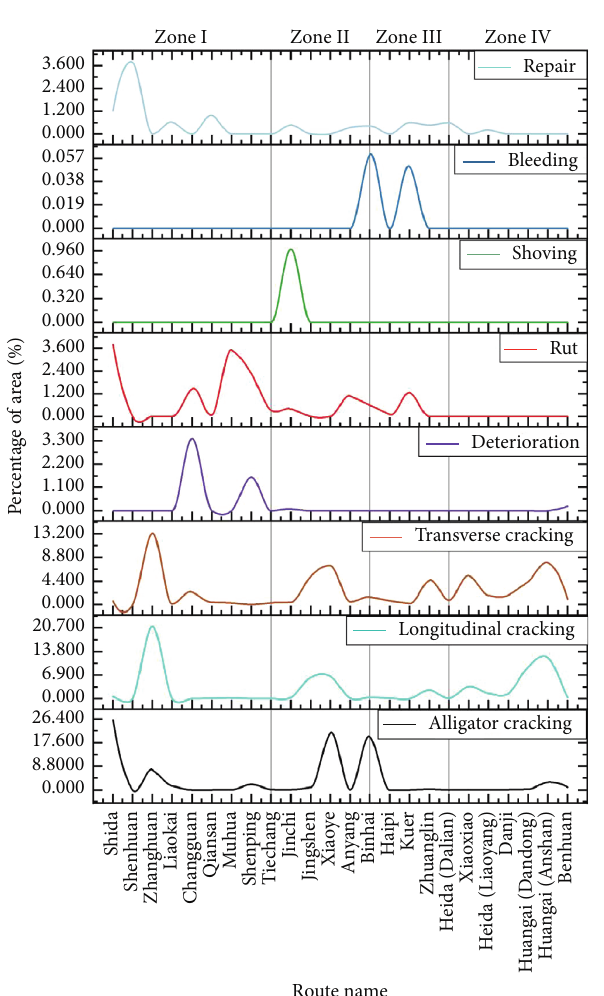
Figure 16: The percentage of degradation area on each